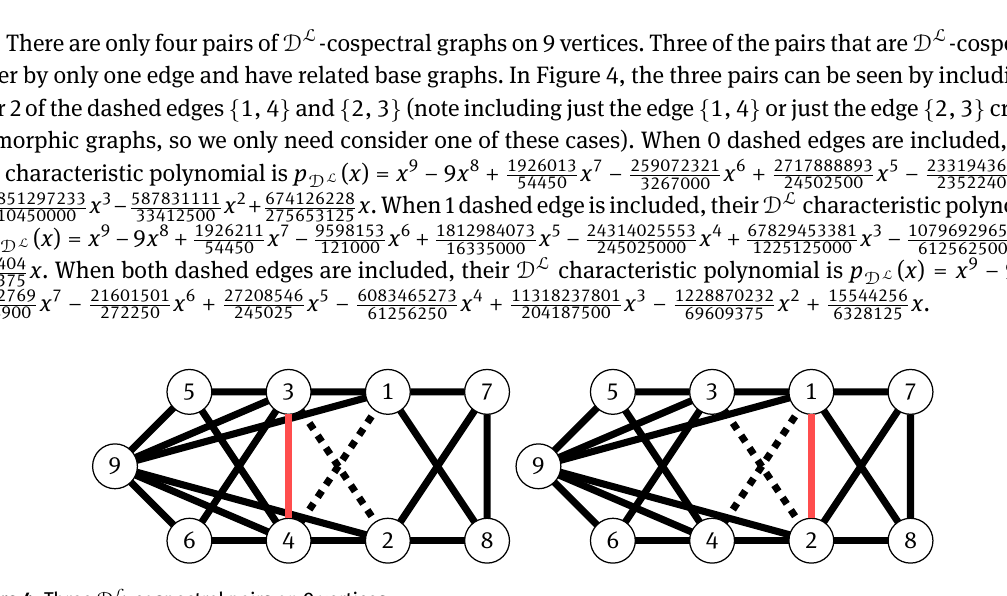
There are only four pairs of D L -cospectral graphs on 9 vertices. Three of the pairs that are D L -cospectral